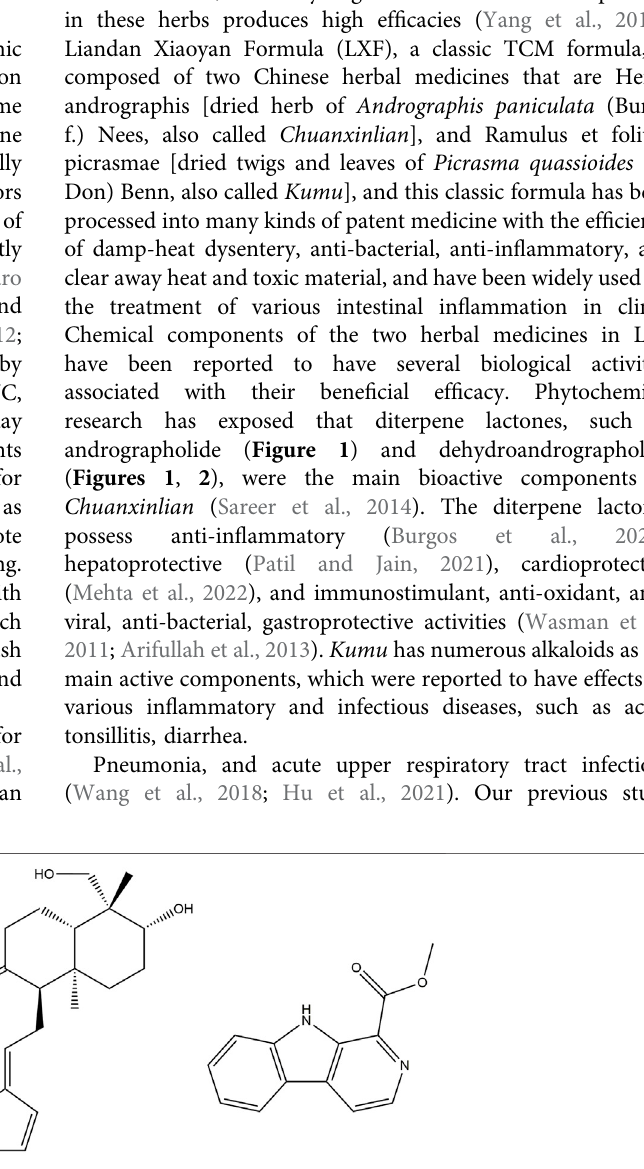
Frontiers in Pharmacology |